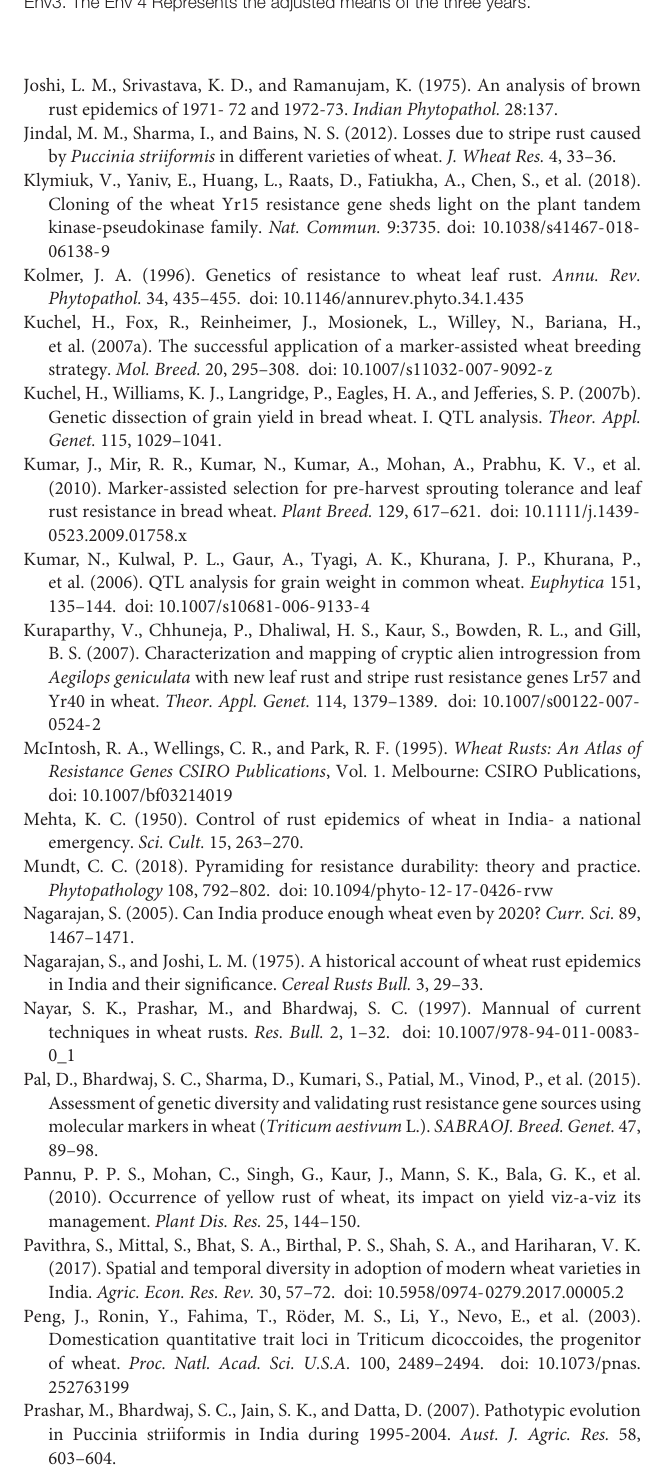
non-template control and pink color represents unamplified or unclustered samples. Supplementary Table 1 | Raw data of thousand grain weight in three-year replicated trials as recorded on BC 2 F 3 − 5 progenies of cross PBW343 X Rye